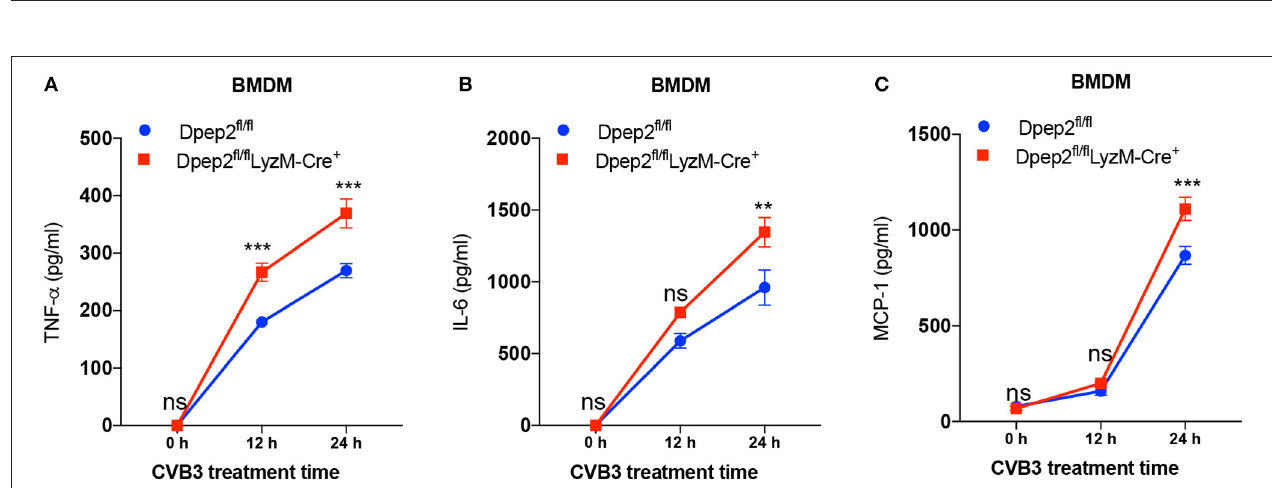
FIGURE 4 | Dpep2 inhibited pro-inflammatory cytokine production by macrophages. BMDMs derived from Dpep2 fl / fl LyzM-Cre + or Dpep2 fl / fl mice were treated with CVB3 (MOI = 10) for 12, 24h. (A–C) Levels of pro-inflammatory cytokines TNF- α , IL-6, and MCP-1 in the supernatants were detected by ELISA. Individual experiments were conducted three times with similar results and the representative data were shown. Data were presented as the means ± S.E.M. ** p < 0.01; *** p < 0.001; ns, no